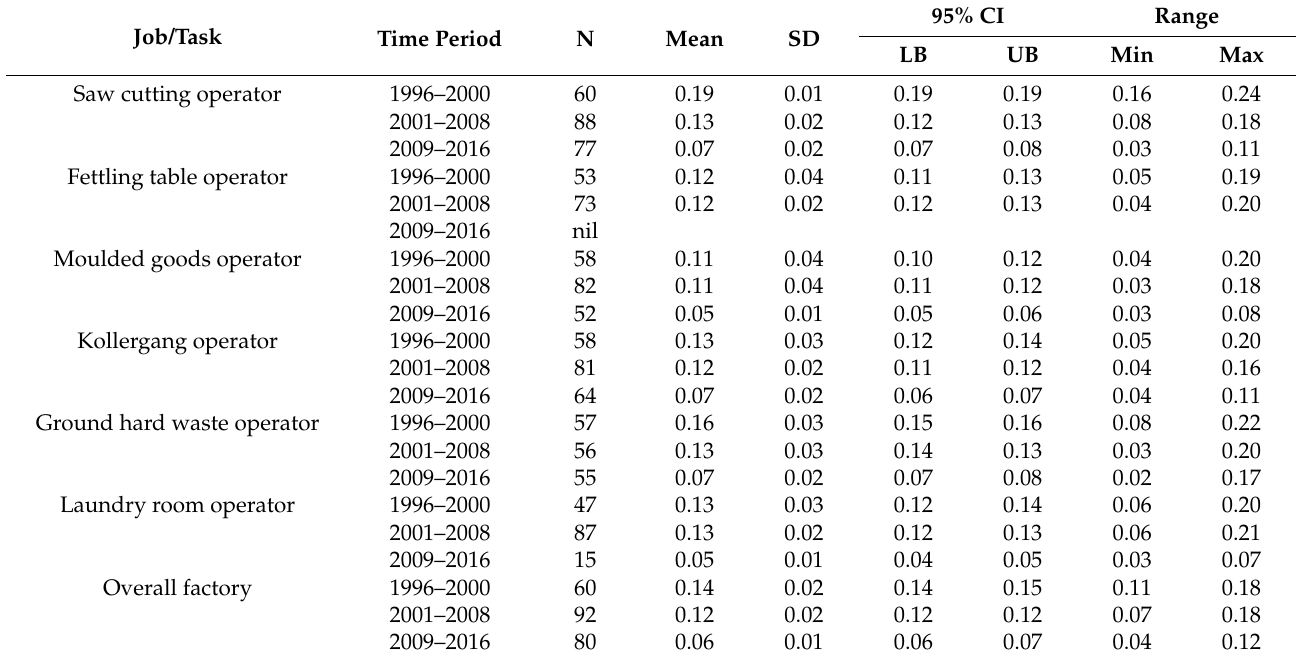
Table 4. Mean personal exposure chrysotile asbestos fibre concentrations (f/mL) by period between 1996 and 2016: Harare factory.